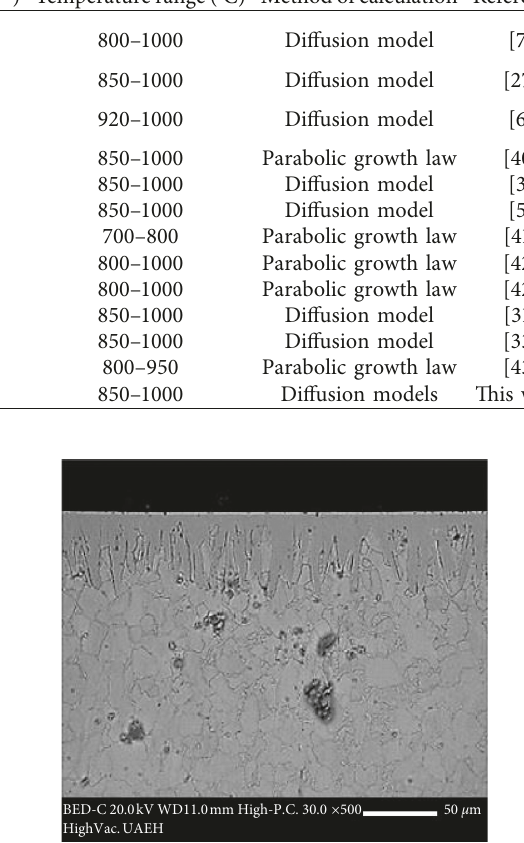
Figure 9: Arrhenius relationship for the boron diffusion coefficient ( D diffusion model). Table 3: Reported values of activation energies for boron diffusion in ASTM A36 steel with other borided Armco iron and steels. Material Boriding method